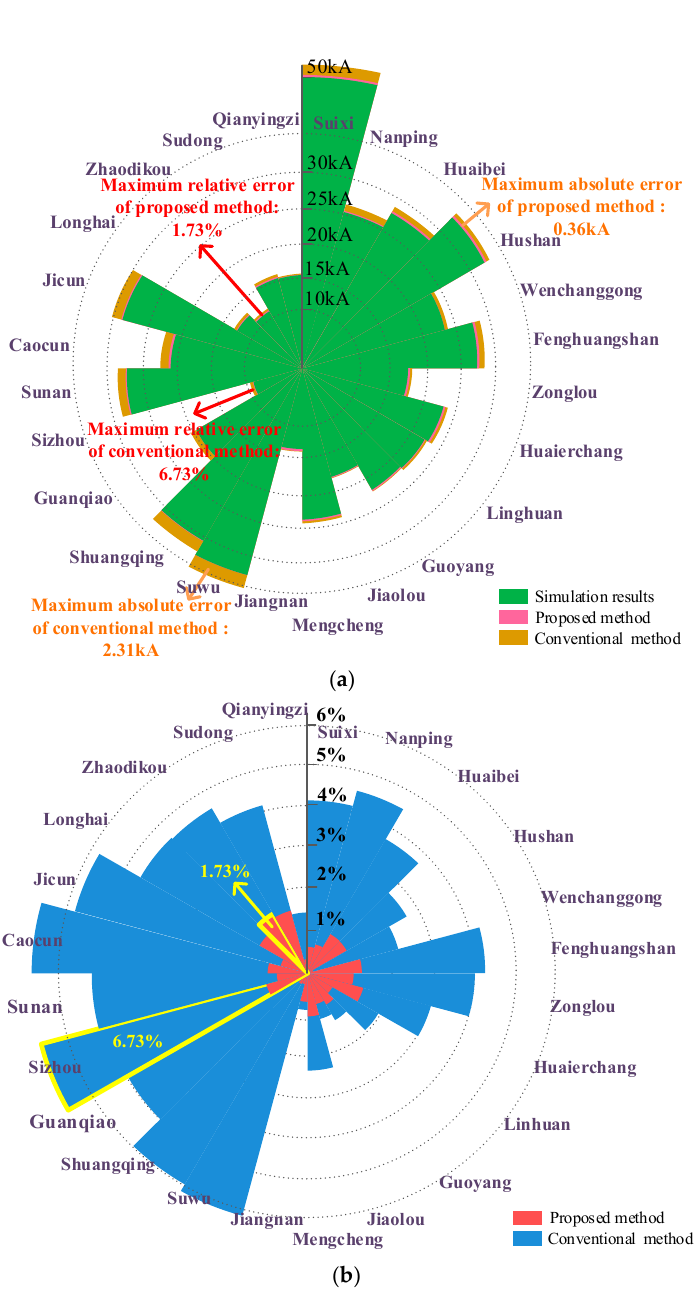
Figure 17. Initial value of AC component of substations. ( a ) initial AC component value; ( b ) comparison of relative errors of initial AC components.